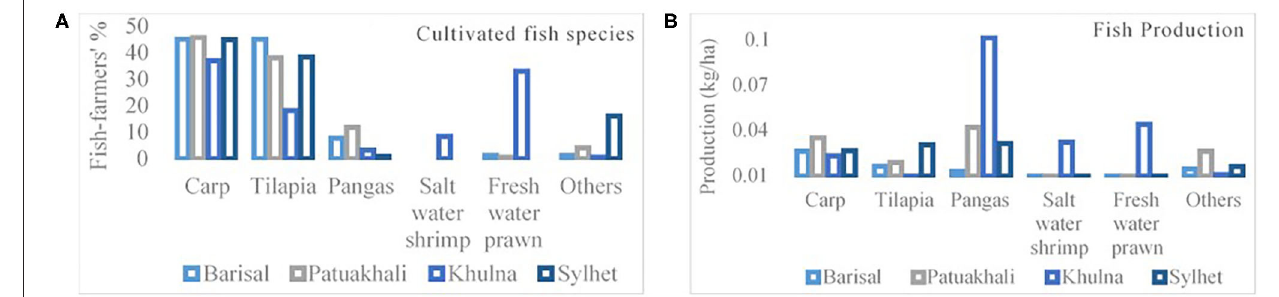
FIGURE 5 | Fish species cultivated and corresponding production levels in